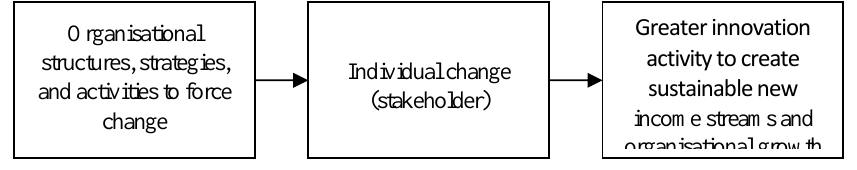
Fig. 1. Conceptual